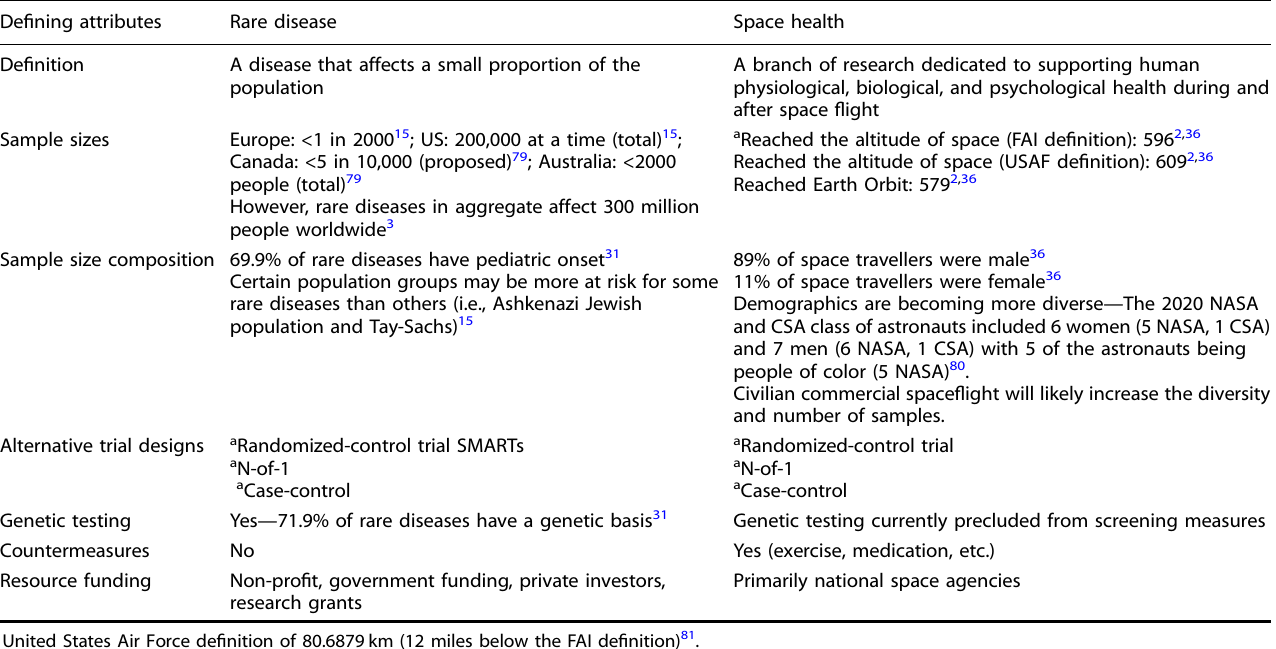
Table 1. Comparison of key descriptive characteristics pertaining to rare diseases and space health. De fi ning